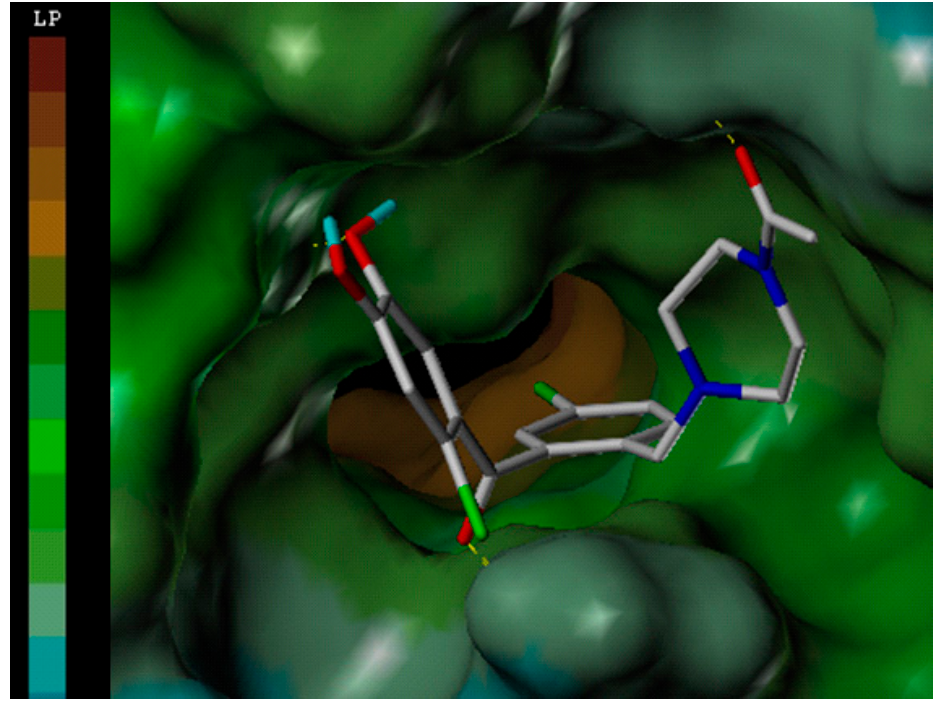
Figure 2. The potential energy diagram of compound 22b binding with the Keap1 Kelch domain. (The small molecule 22b was presented by a stick model.)